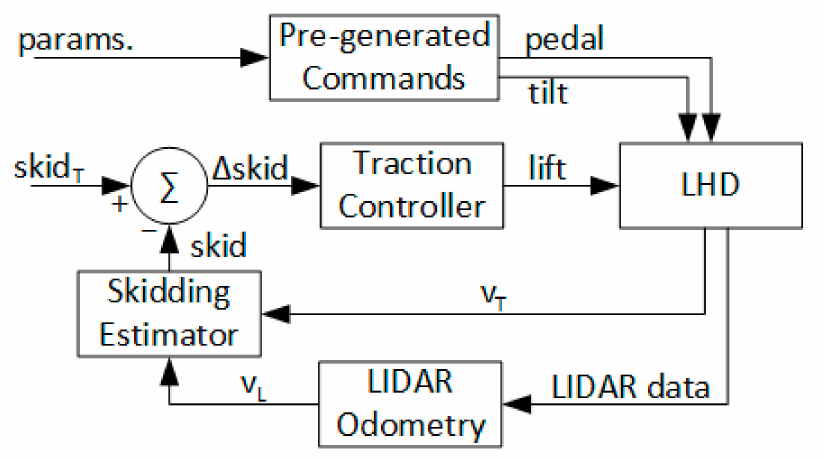
Figure 16. Detection of the collision with the rock pile. Through analysis of the manual operation data, the transmission pressure signal and the estimated skidding factor were selected and used in a threshold detector.